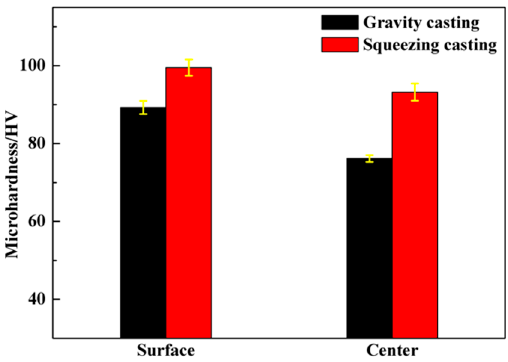
Figure 4. Micro-hardness of the alloy formed by squeezing casting and gravity casting technology.